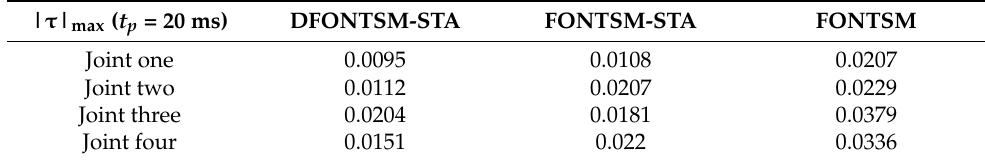
Table 13. The maximum variation of control torque in a small interval.